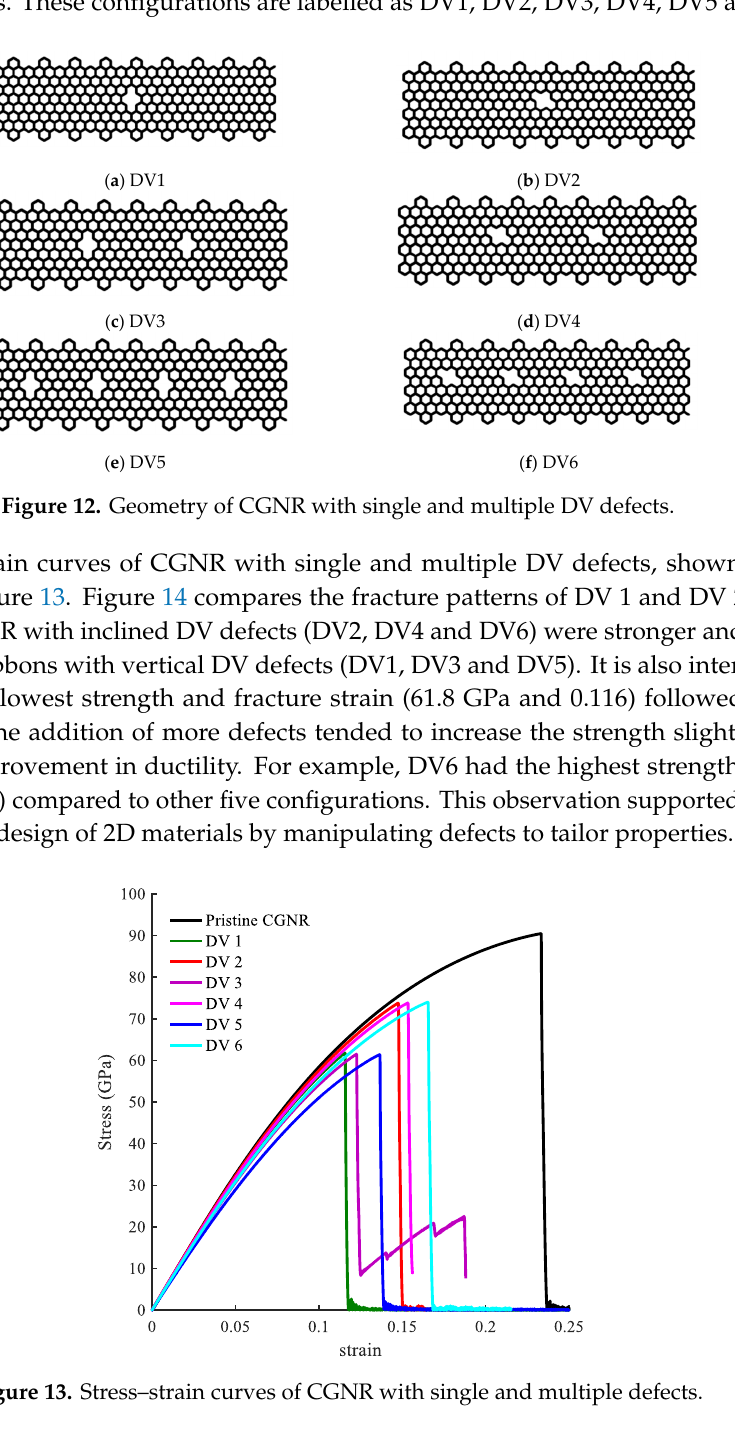
Figure 13. Stress–strain curves of CGNR with single and multiple defects.